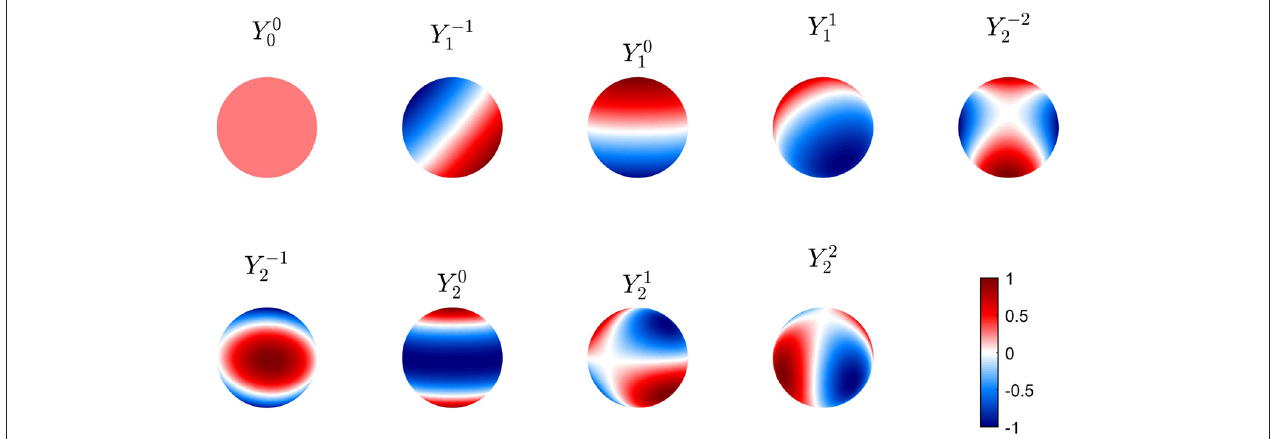
FIGURE 6 | First nine real eigenmodes Y m l on a spherical cortex. In each case the mode is normalized to a maximum amplitude of unity and regions of opposite sign are shown red and blue as in the color bar.